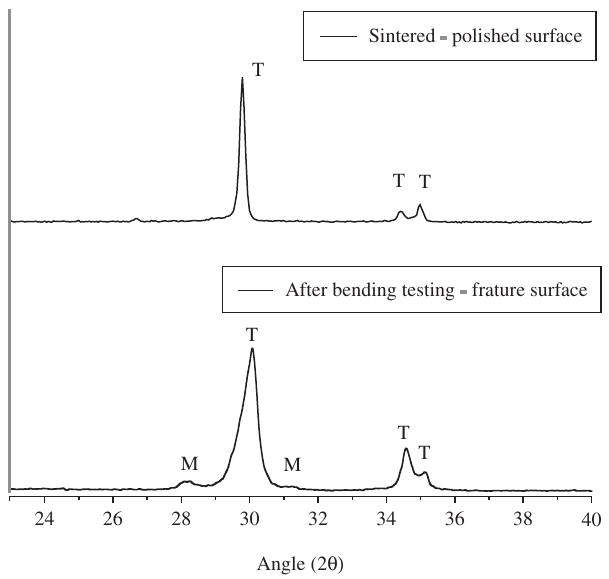
Figure 1. X ray diffractogram patterns: a) polished surface after sintering at 1600°C and b) fracture surface after bending testing. (T - tetragonal; M - monoclinic).